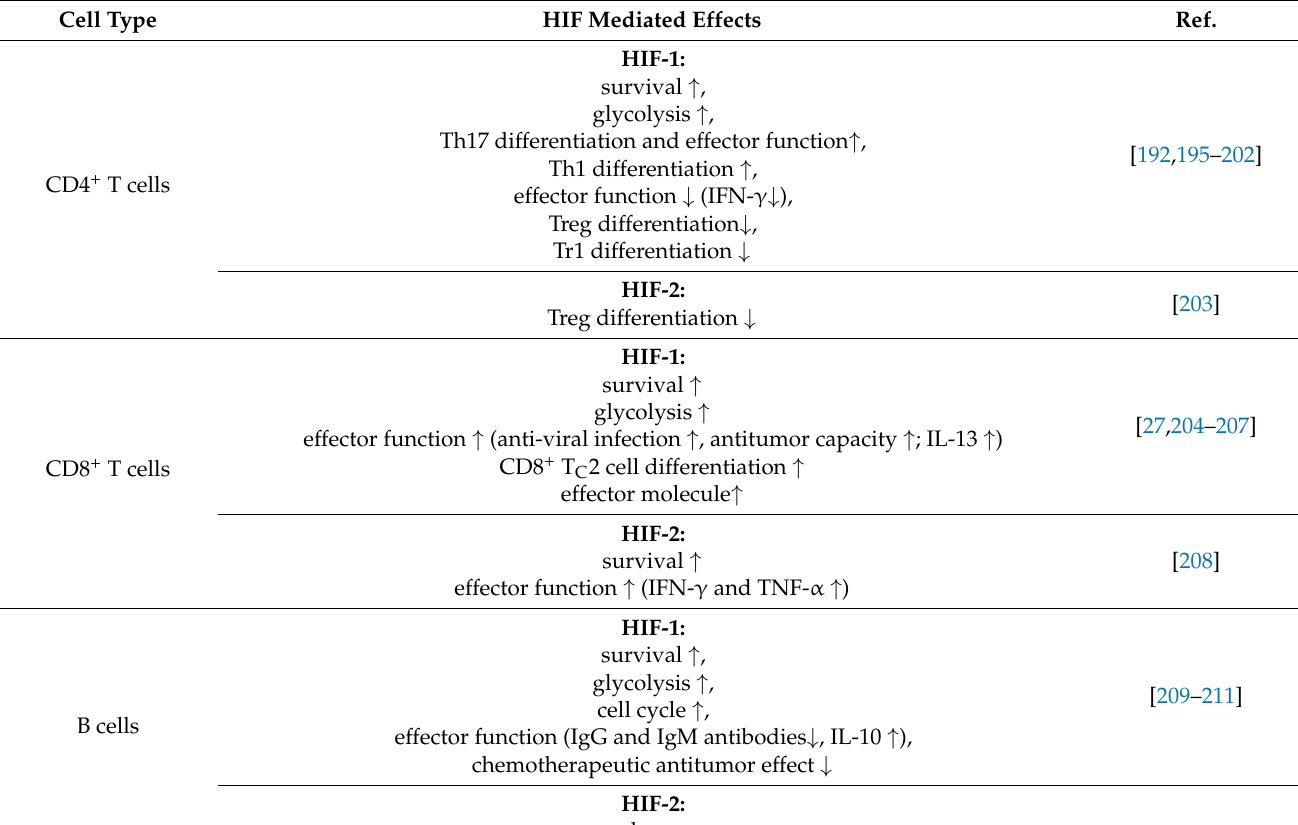
Table 2. HIF-mediated effects in lymphoid